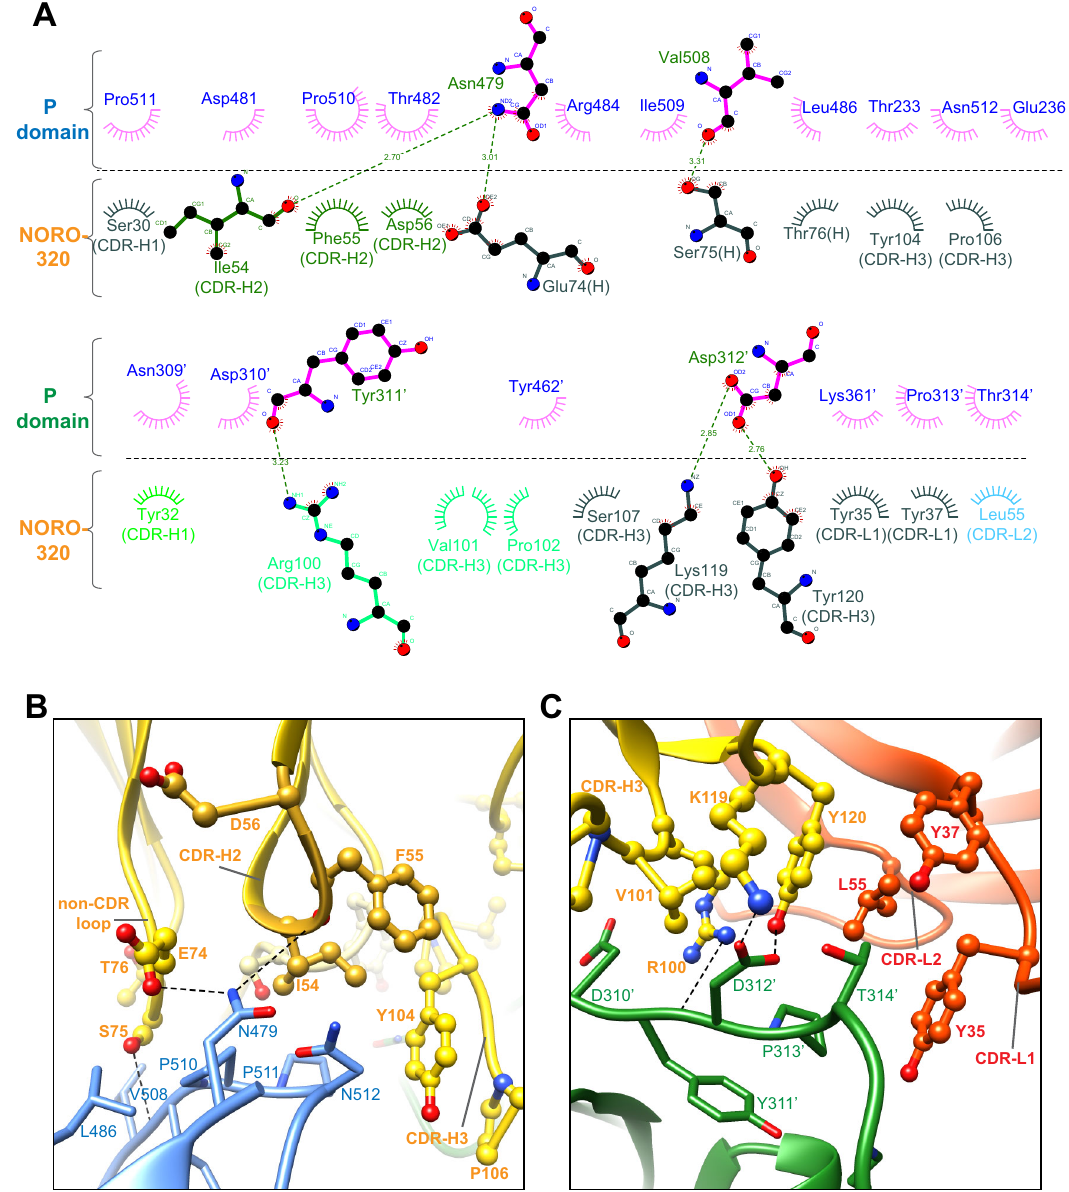
Fig. 7 Molecular interactions between NORO-320 and GII.4 P-domain. A Antibody plot analysis using the program LigPlot + v.2.1 49 . The P2 subdomain residues in the 2-fold related subunit are hyphenated. The hydrogen bonds are shown as green dashed lines, and the hydrophobic contacts are short spokes radiating from each atom or residue. B , C The interactions of P1 or P2 subdomains with NORO-320. The side chains of mAb and P-domain are represented with ball-and-stick and stick models, respectively, and colored as in Fig. 4. The hydrogen bonds are shown as black dashed